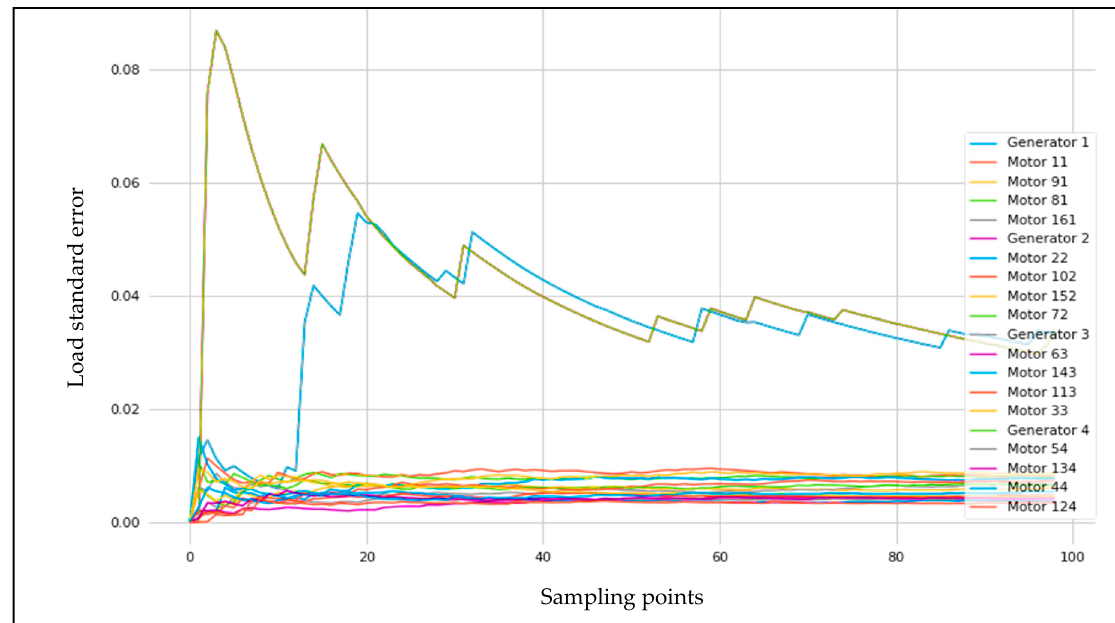
Figure 25. Latin hypercube standard deviation for the cruising case study.